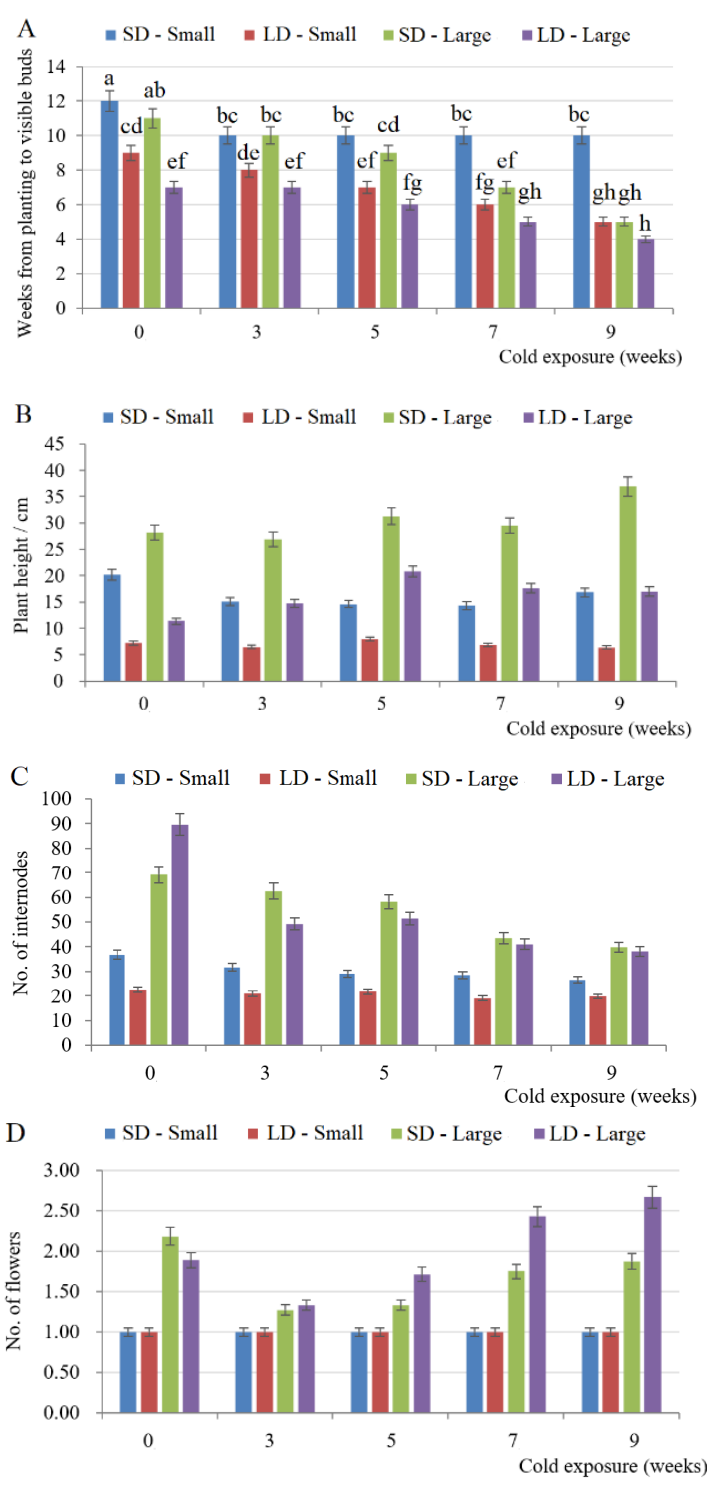
Figure 1. Effect of cold exposure and photoperiod on the flowering time and morphological charac- teristics of different sized bulbs of Lilium longiflorum . ( A ) Time from planting to visible flower bud appearance. ( B ) Plant height at visible bud appearance stage. ( C ) Number of internodes at visible bud appearance stage. ( D ) Average number of flowers. Notes: SD, short day (light/dark: 8/16 h); LD, long day (light/dark: 16/8 h); Small and large, bulb size; 0 – 9, weeks of bulb exposure to 4 °C before planting. Different lowercase letters indicate significant differences ( p < 0.05). Table 1. Flowering rate of small and large bulbs grown under SD/LD conditions.